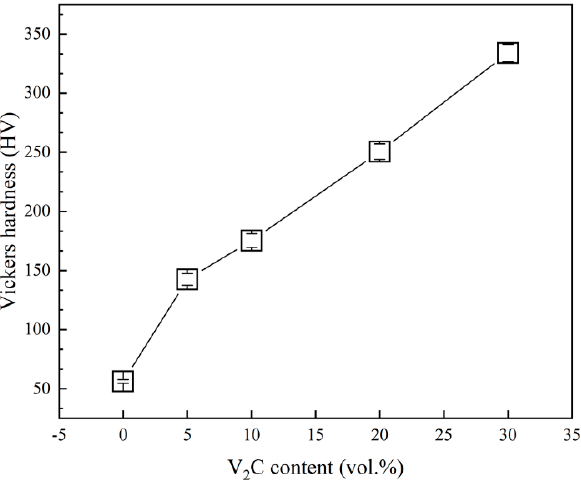
Figure 8. Vickers hardness of Cu composites as a function of V 2 C content.